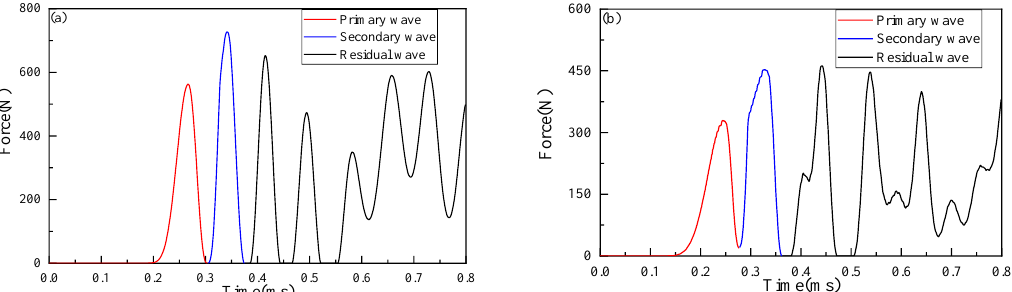
Figure 5. Contact force-time curves at different granule positions of Case 3 ( λ = 1): ( a ) Granules 9 and 10 in homogeneous elastic – plastic granular chain; ( b ) Granules 7 and 8 in an inhomogeneous elastic – plastic granular chain.